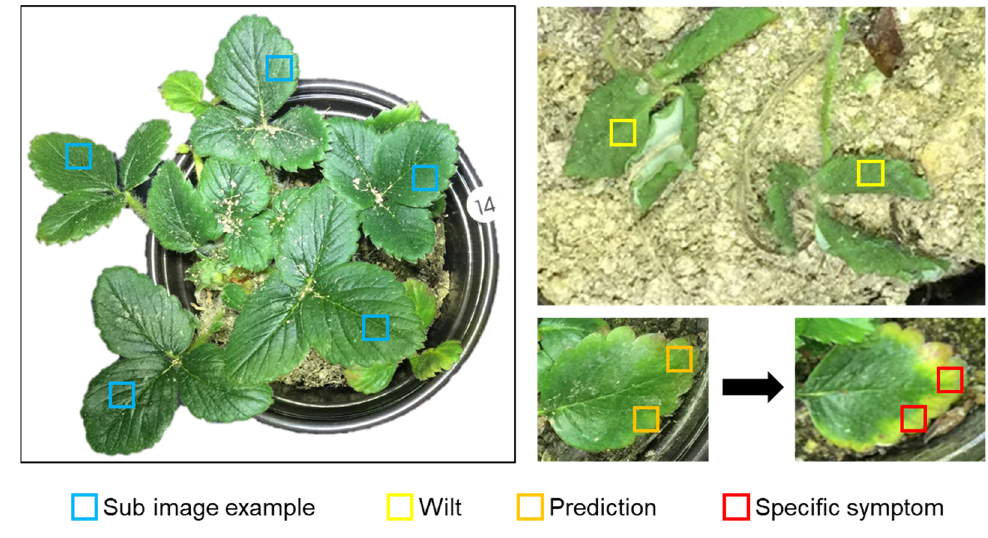
Figure 4. Example of obtaining subimages corresponding to each class from hyperspectral images of leaves.